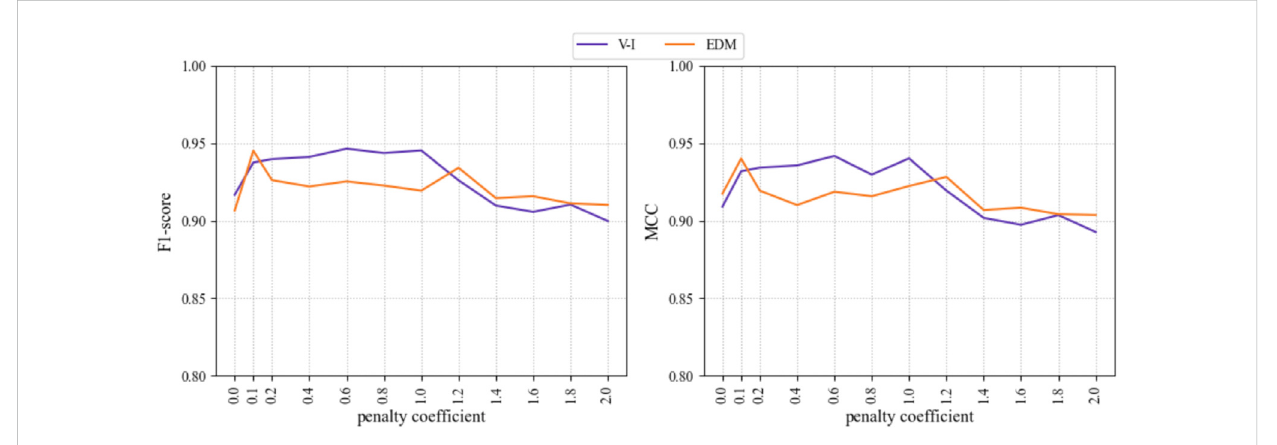
FIGURE 3 Effect of different penalty coef fi cients on the DRO model with PLAID data.